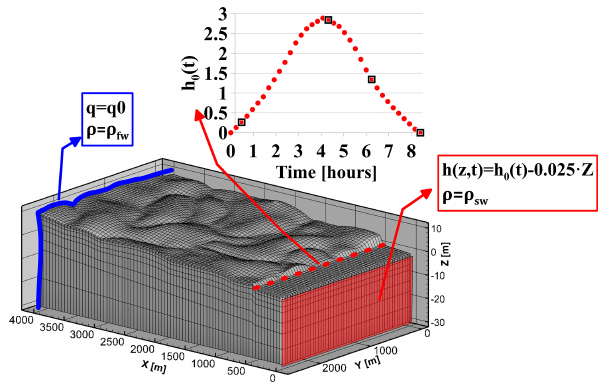
Figure 2. Hydrogeosphere model domain as a function of the verti- cal Z , cross-shore X , and alongshore Y dimensions, boundary con- ditions (red and blue boxes), and the surge height evolution curve (inset). The blue curve is the terrestrial freshwater recharge bound- ary, the red rectangle is where a fixed seawater head and concentra- tion are applied to the subsurface domain, and the red dashed line is where the sea level height boundary condition ( h 0 (t) ) is applied to the surface domain. For the steady-state simulations h 0 (t) = 0 and for the transient simulations, the curve in the inset is applied. The black squares in the inset mark the times plotted in Fig.